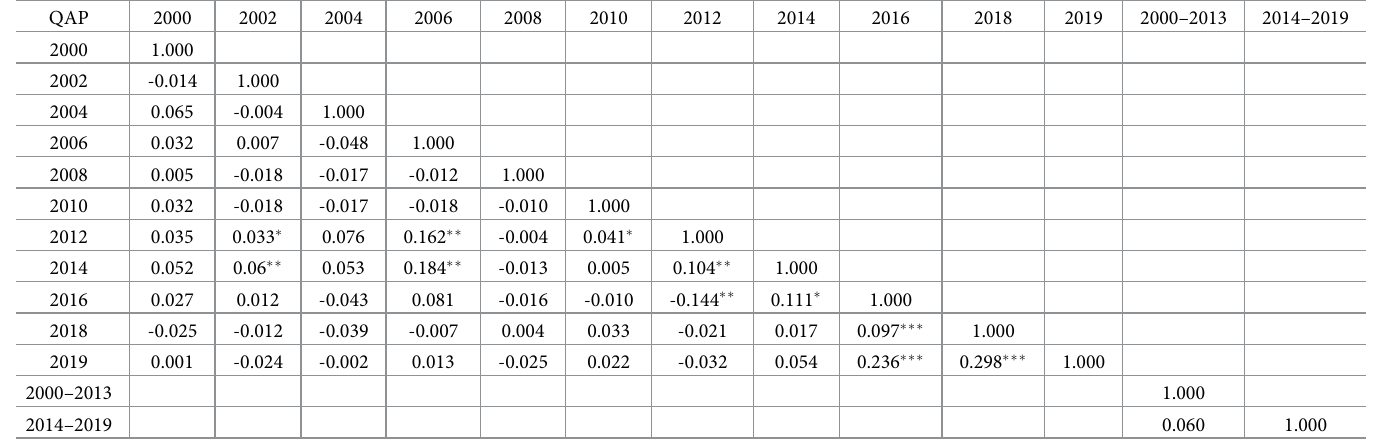
Table 2. QAP correlation